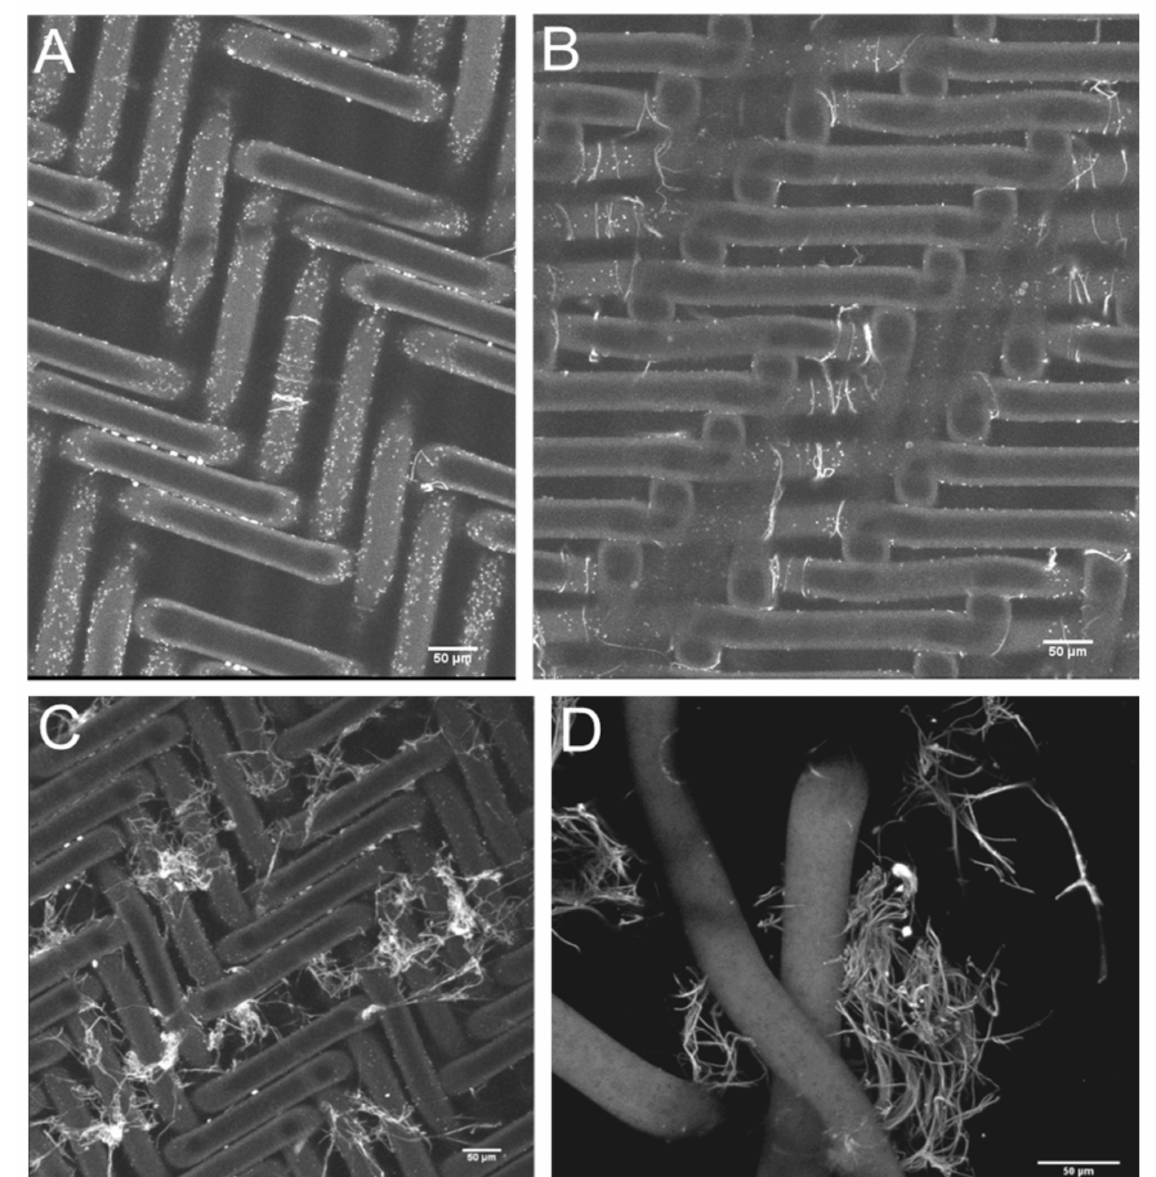
Figure 3. The sieve fabric is woven in a herringbone pattern from 35 µ m diameter nylon filaments. Images ( A – C ) are 3D reconstructed, maximum intensity, images collected with a 20 × air objective of 6 z-stacks (1.3 µ m slices) of a centered tile grid 2 × 2 with 10% overlap. The herringbone-pattern nylon grid was stained with Sypro Ruby Biofilm Matrix stain. ( A ) The pores in the sieve are nominally 10 × 35 µ m and groups of four pores in a depression in the fabric are in the base of each of the four darker rectangular areas of the grid. The small white fibrils are the earliest indication of SF having transformed into insoluble fibrin microfibrils. The tiny white dots also precipitate along with the fibrin fibrils and disappear later as fibrinolysis commences. They possibly represent amyloid type fibrin rather than the properly polymerized variety. ( B ) Approximately ten minutes after the start of fibril formation, several longer fibrils are draped over the nylon filaments that bridge between adjacent sieve-pores. ( C ) Approximately twenty minutes into the process of microclot formation, small early microclots are now evident. ( D ) The woven nylon filament grid has been disrupted and the forming microclots have been recovered, fixed and stained. Three torn nylon filaments from the disrupted sieve can be seen in the foreground. 3D reconstructed, maximum intensity images collected with a 10 × air objective of 11 z-stacks (6.62 µ m slices). Sypro Ruby Biofilm Matrix